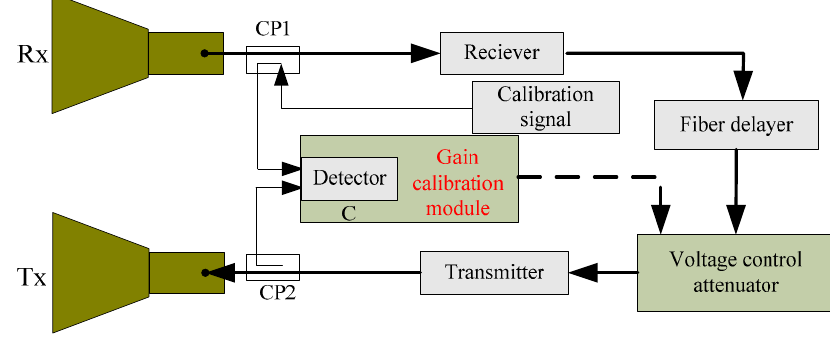
Figure 5. Gain calibration circuit scheme.